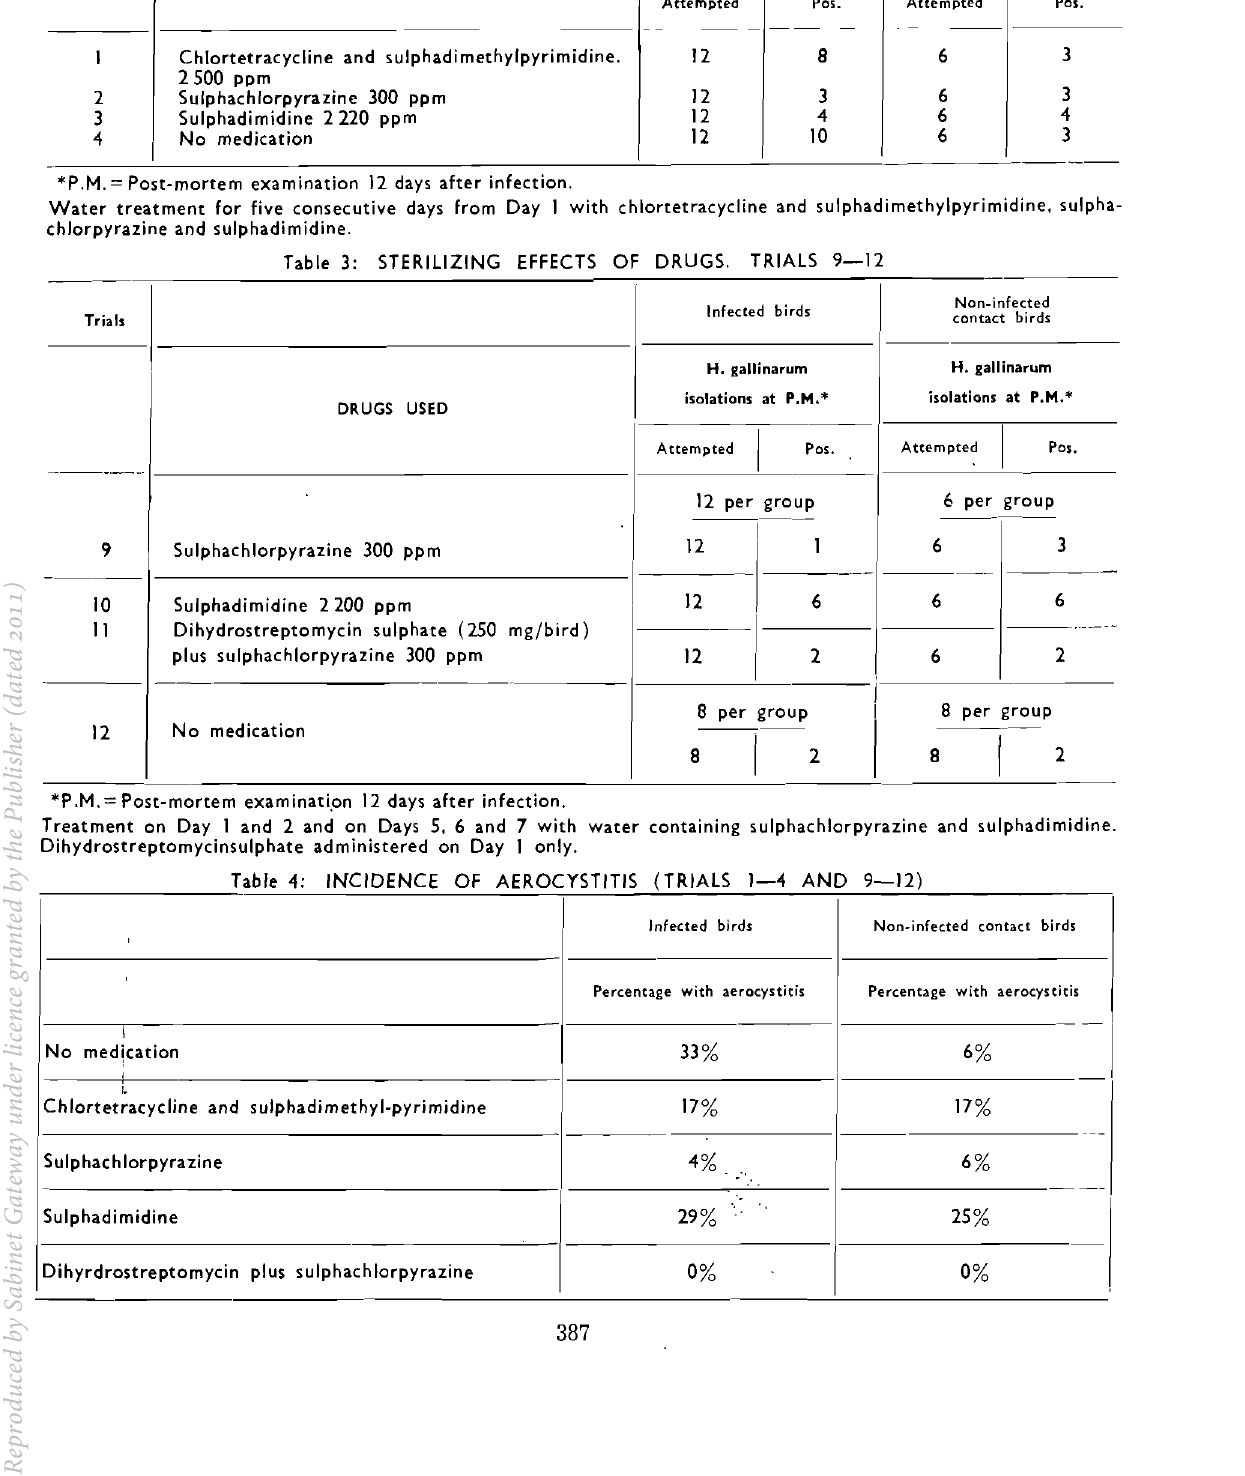
Table 2: STERILIZING EFFECT OF DRUGS, TRIALS 1-4 . DRUGS USED